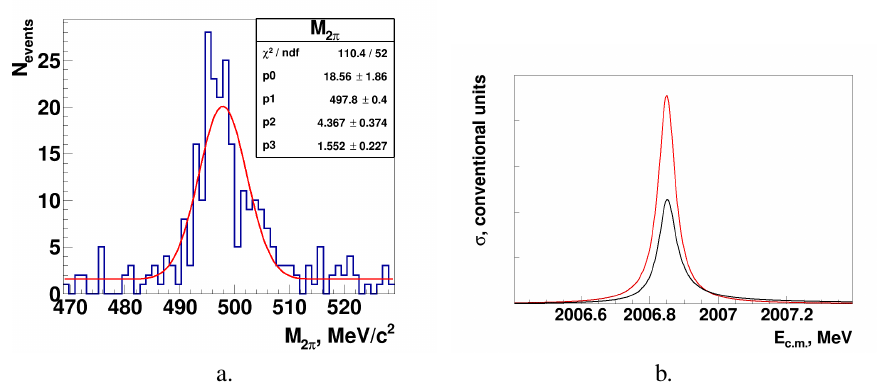
Figure 2. a.) M π + π − for K 0